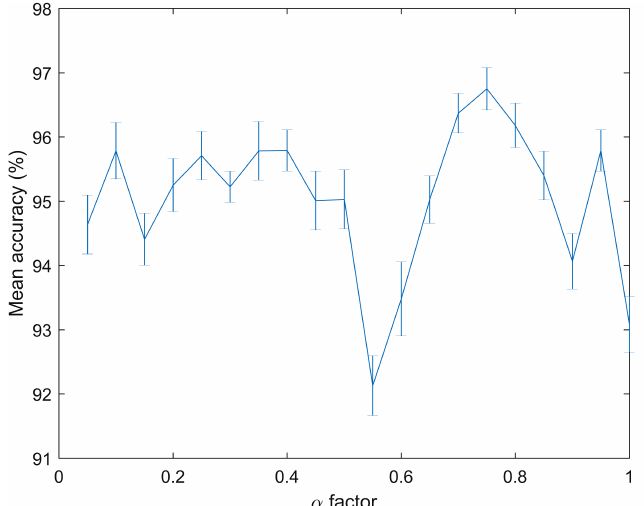
Figure 1. Graph showing the accuracy obtained when fixing the number of neurons and changing the α factor.